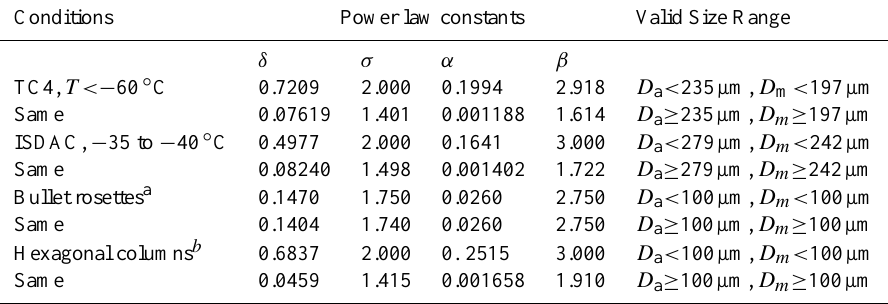
Table 1. Projected area- and mass-dimensional power law constants for relationships of the form A = δD σ and m = α D β that were used in this study. The power law transition dimensions for area and mass are denoted as D a and D m , respectively. Units are cgs.